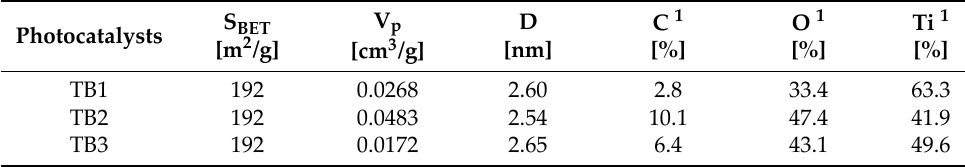
Table 1. The physicochemical properties of tested materials.